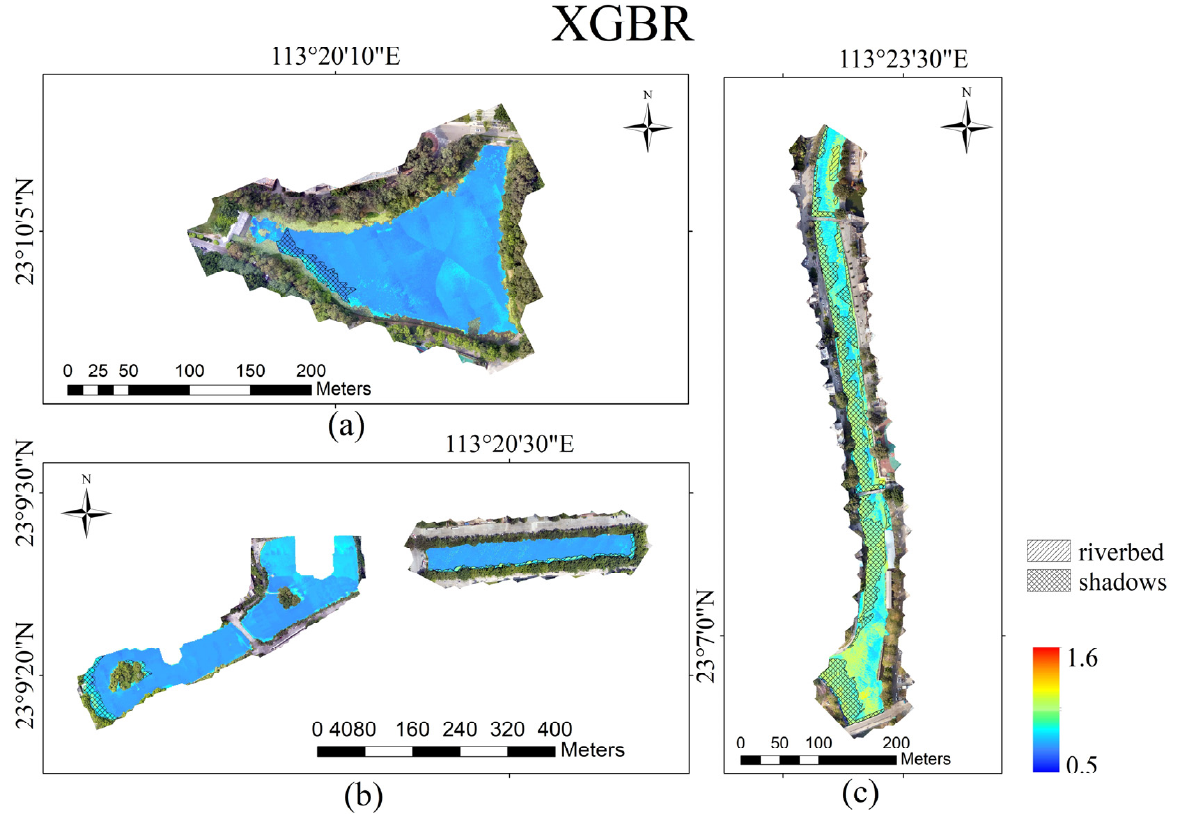
Figure 8. Shadow and rare riverbed in inversion map based on the XGBR model. ( a ) North Lake. ( b ) West Lake and Middle Lake (left); East Lake (right). ( c ) Chebei River.